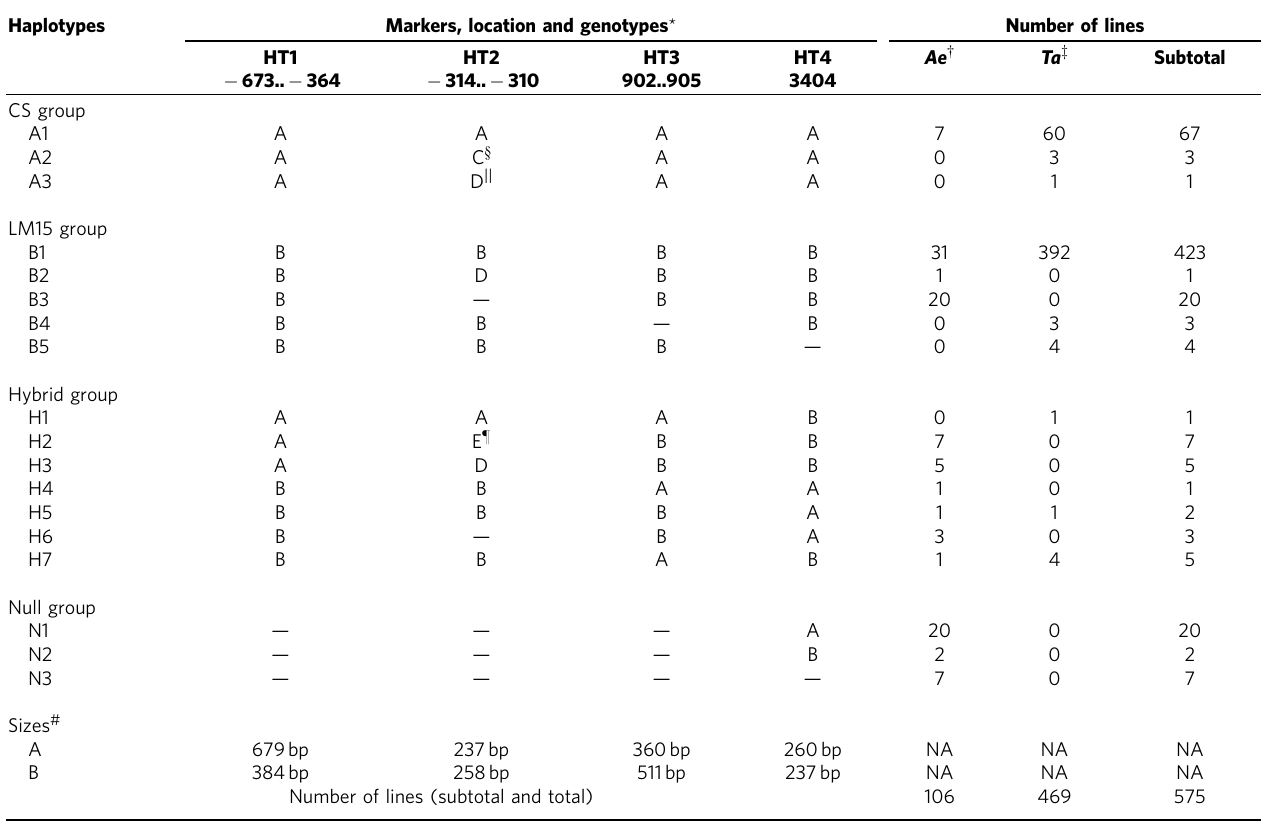
Table 1 | Haplotype analysis of the MS2 gene in common wheat and Ae. tauschii . Haplotypes Markers, location and genotypes * Number of lines